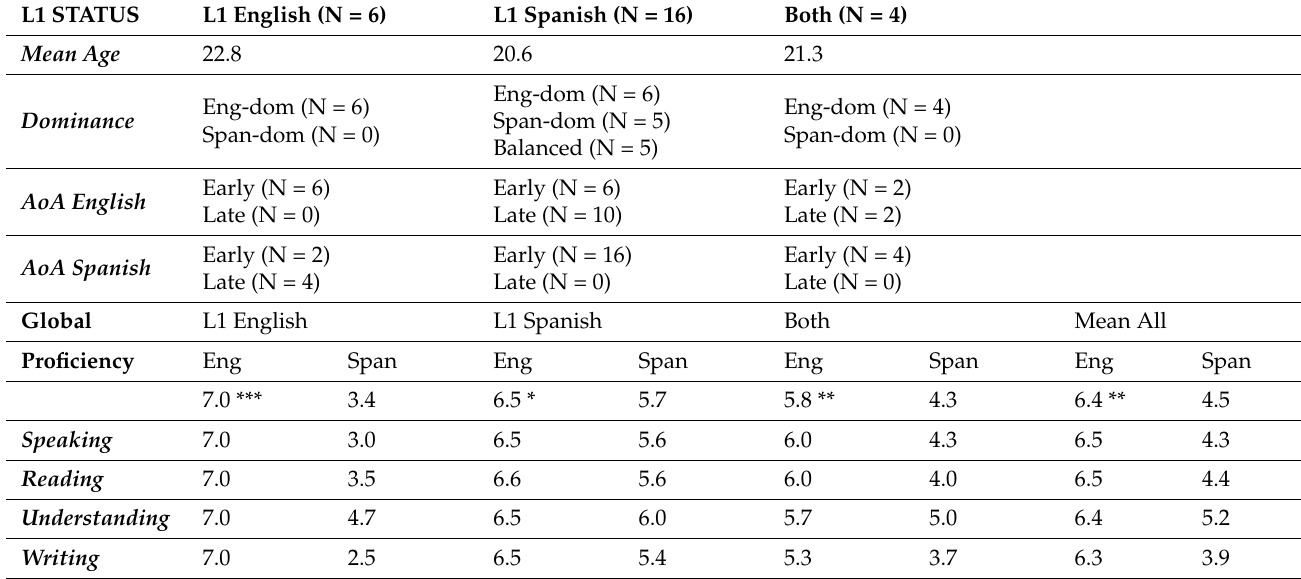
Table 1. Participants’ language background information. Proficiency rating was measured with a 7-point Likert scale where 1 = very poor, 7 = native like. Asterisks show significant differences in proficiency ratings for English and